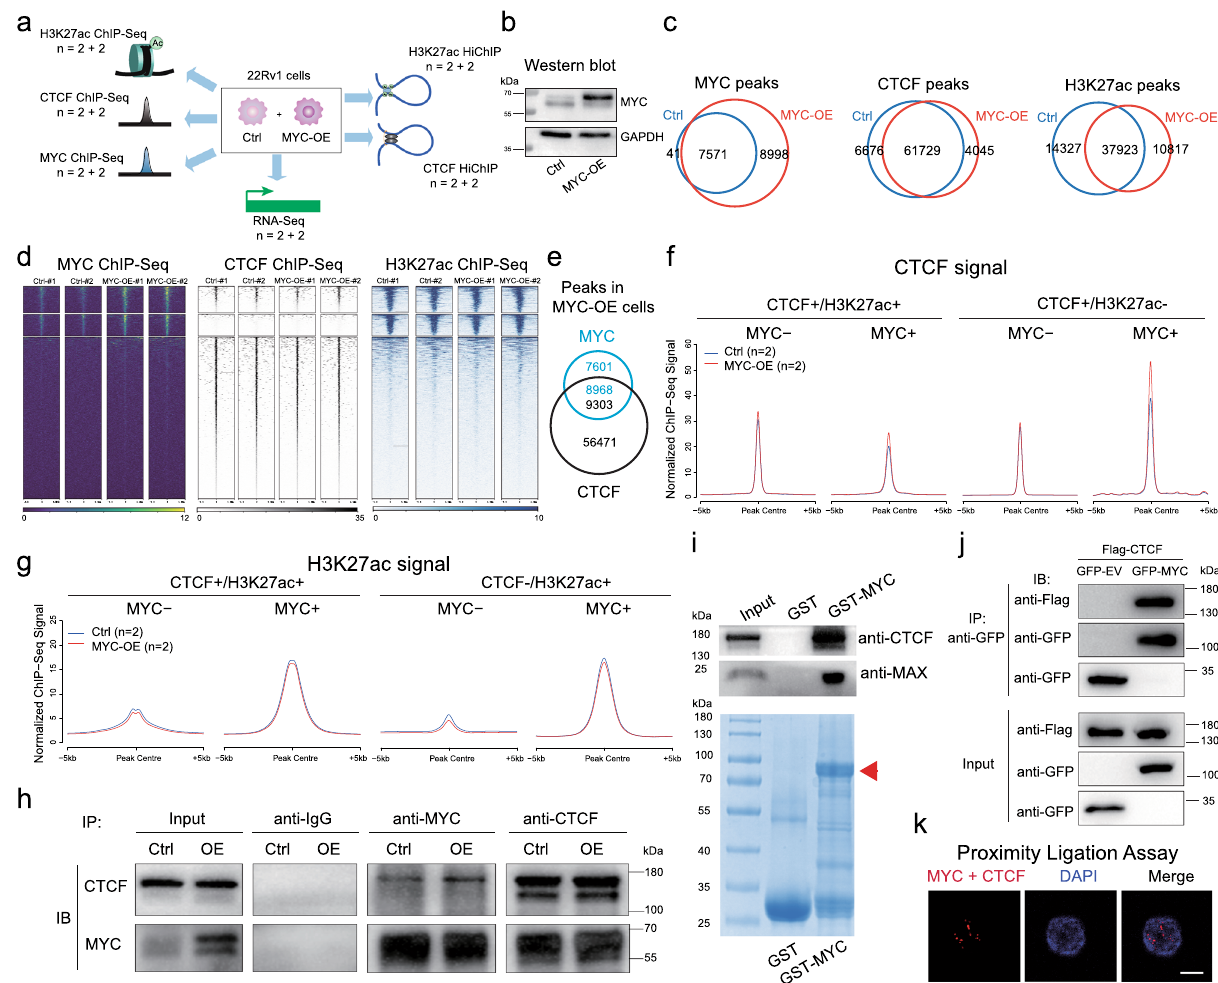
Fig.4|MYCfacilitatesCTCFchromatinbinding.a Multi-omicsassaystoevaluate the function of MYC on CTCF binding and looping in 22Rv1 cells. b Western blot assay showing the ef fi ciency of MYC overexpression. c The overlap of MYC, CTCF and H3K27ac peaks between control (Ctrl) and MYC overexpression (MYC-OE) cells. d Heatmaps showing the ChIP-Seq signalof MYC, CTCF and H3K27acatMYC and CTCF peaks. From top to bottom, MYC and CTCF peaks were separated into shared, MYC-only, and CTCF-only groups. e The overlap between MYC and CTCF peaks in MYC-OE cells. f The aggregated CTCF ChIP-Seq signal in Ctrl and MYC-OE cells.CTCFpeaksweredividedintofourgroupsbasedonMYCandH3K27acstatus. g The aggregated H3K27ac ChIP-Seq signal in Ctrl and MYC-OE cells. H3K27ac peaks were divided into four groups based on MYC and CTCF status. h Co-